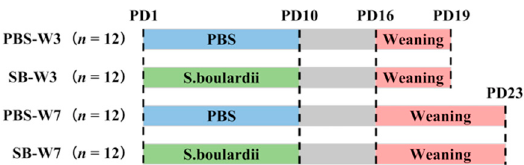
Figure 1. Experimental design. We chose 6 pregnant Wistar rats and monitored them daily until parturition. After birth, each litter was culled to a size of 8 pups. On PD1, pups were randomly divided into two groups (PBS or SB) in each litter. Rats in the PBS groups were fed with PBS once per day from PD1 to PD10; rats in the SB groups were fed with 1 × 10 9 CFUs of S. boulardii once per day from PD1 to PD10. All pups were weaned on PD16. On PD19, 4 rats from every litter from two groups were randomly chosen and were asphyxiated by CO 2 inhalation and sacrificed. On PD23, the rest of the rats were asphyxiated by CO2 inhalation and sacrificed.